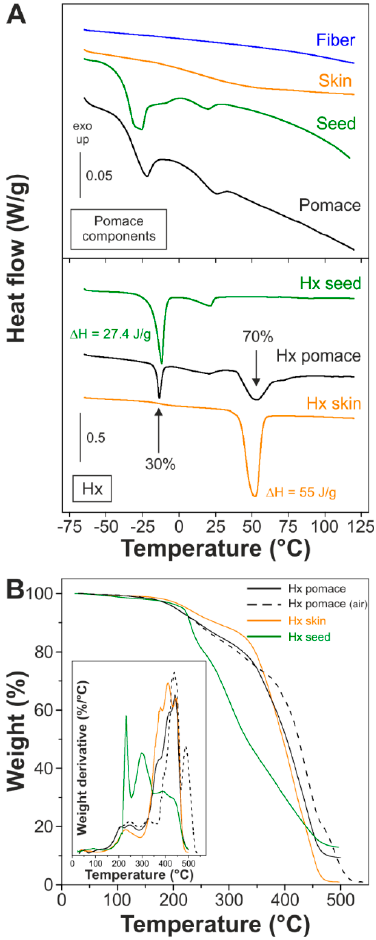
Figure 2. ( A ) DSC of isolate tomato pomace constituents and their hydrolysable fractions (Hx). ( B ) TGA of Hx fractions. of Hx